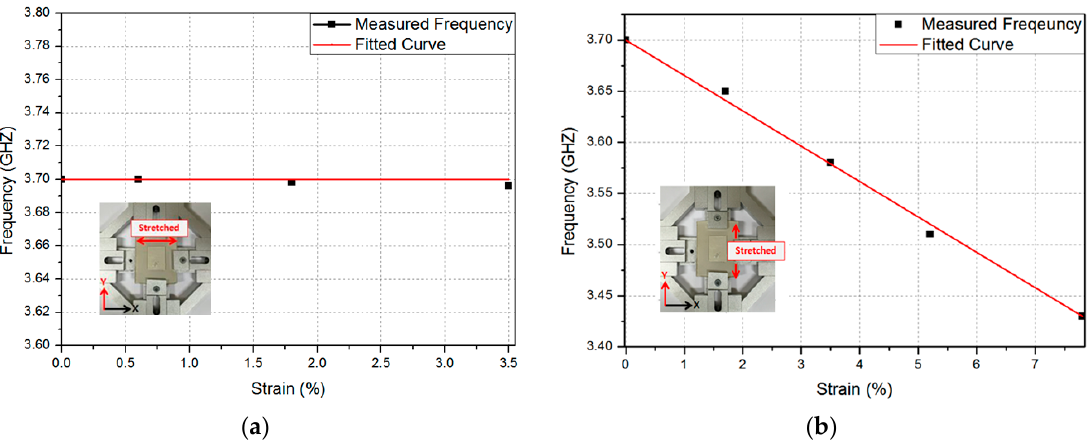
Figure 8. Relation between the resonant frequency and the strain along the ( a ) x -direction (width) and ( b ) y -direction (length). Table 1. Comparison table of proposed sensor and other RF strain